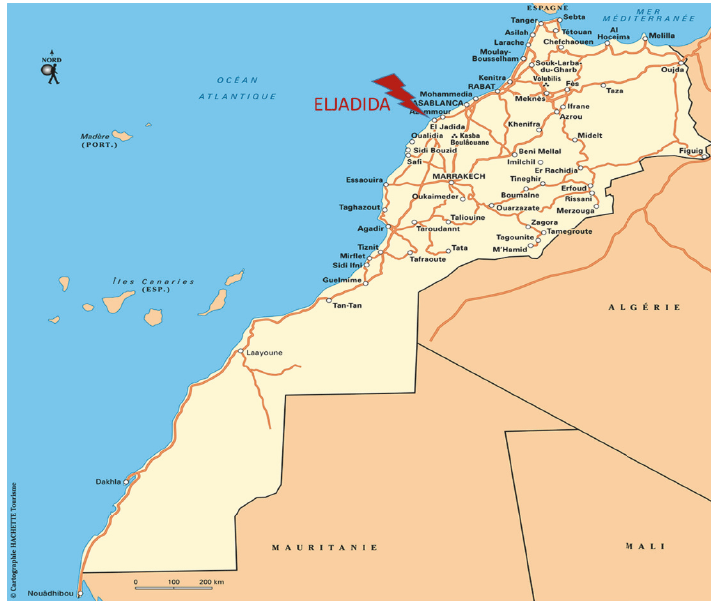
Figure 1: Study area (El Jadida province)